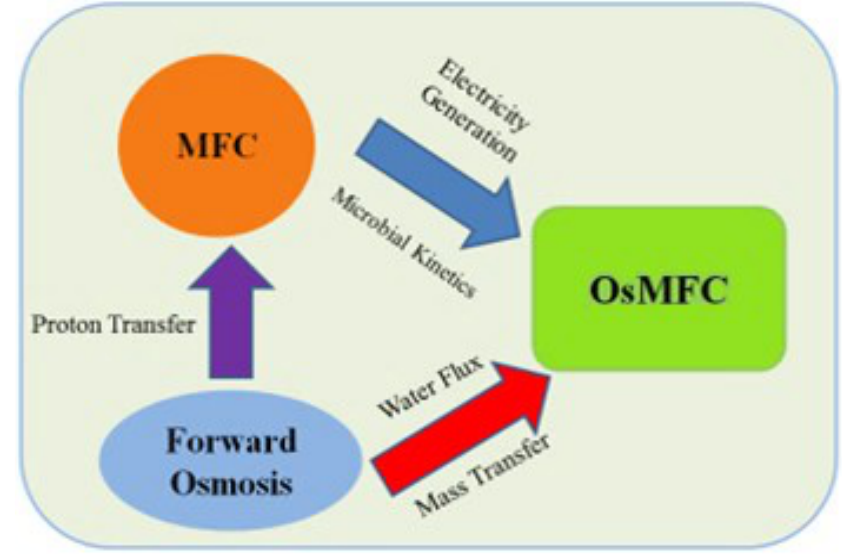
Figure 5. Coupling advantages of forward osmosis technology and microbial fuel